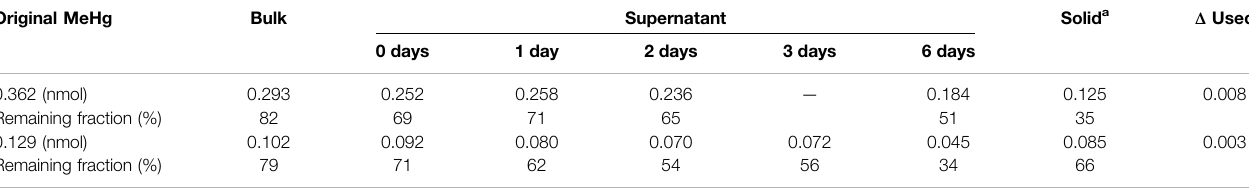
TABLE 3 | The change of MeHg amounts after mixing MeHg with NPs in dark. Δ Used refers to the portion transferred for the concentration determination. Original MeHg Bulk Supernatant Solid